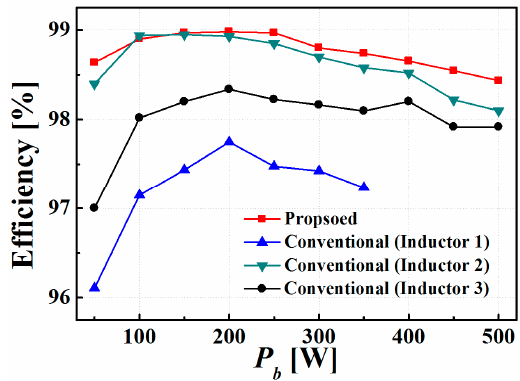
Figure 18. η e vs. P b at V a = 48 V and V b = 36 V.